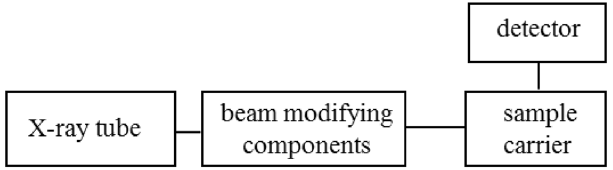
Figure 5. Block diagram of a typical instrument used for